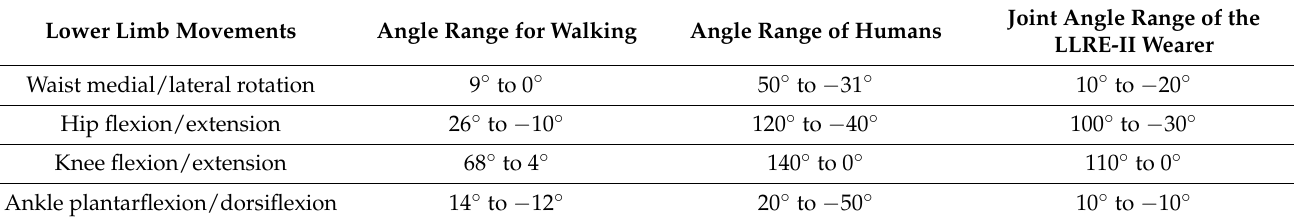
Table 1. Ranges of